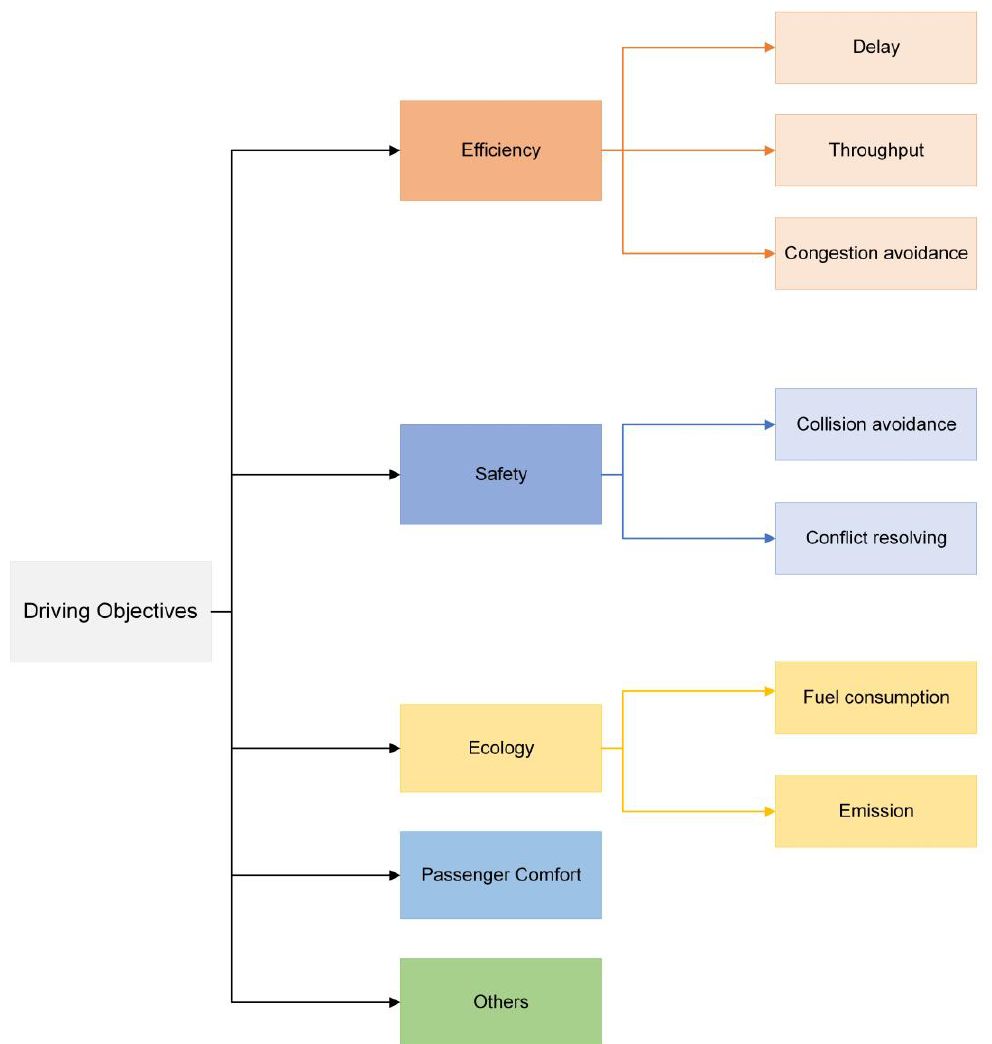
Figure 4. Main driving objectives and